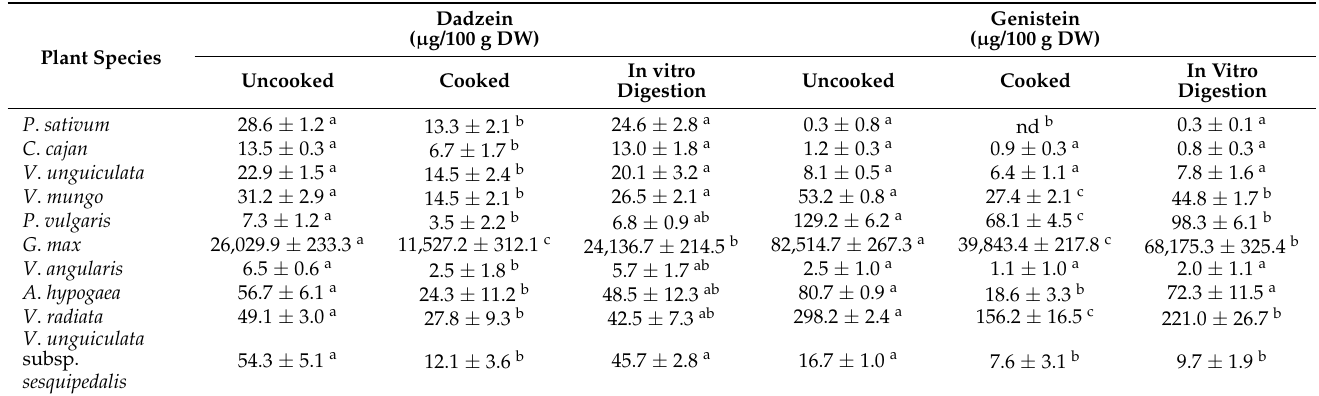
nd: not detected; Different superscript letters indicate significant differences at p < 0.05. Isoflavones are found in the highest concentration in Fabaceae beans and their derived products [17,44]. Genistein and daidzein are the most biologically active isoflavones that might benefit human health found in Fabaceae [18–21]. The varia- tions in the contents for these two isoflavones were large, ranging from 6.5 µ g/100 g DW ( V . angularis ) to 26,029.9 µ g/100 g DW ( G . max ) for daidzein, and from 0.3 µ g/100 g is the richest source of both isoflavones. These results are similar to those reported in the literature (i.e., ranging from 10,500 to 58,000 µ g/100 g for Daidzein, and from 26,800 to 84,100 µ g/100 g for genistein in soy bean for example) [17,44]. The complete ranges have been rewieved by [17,44]. Our results expand our understanding for Thai cultivars for which no database is currently available, as well as for species like V . unguiculata subsp. sesquipedalis that has never been reported previously. The influence of cooking and in vitro digestion on these two isoflavones is shown in Table 4. Cooking reduces isoflavone levels by roughly 50%, similarly to TFC, however digestion has a less pronounced impact and even facilitates their releases (Table